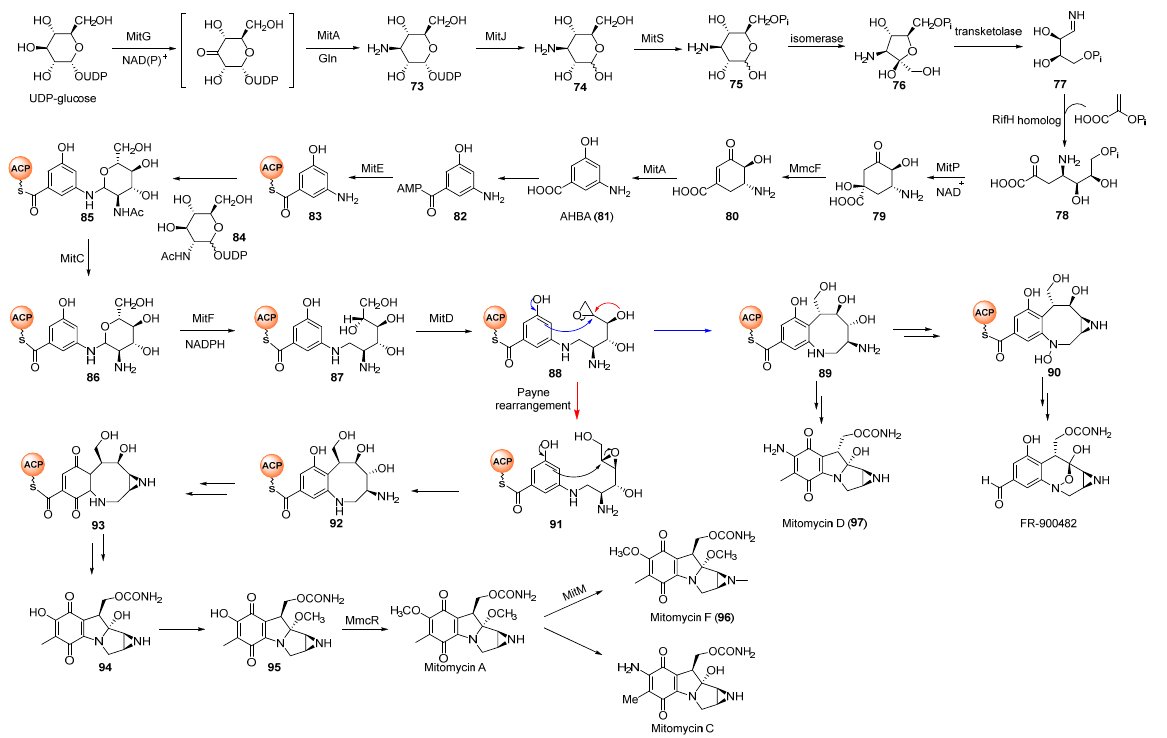
Figure 11. Proposed biosynthetic pathway of mitomycins.